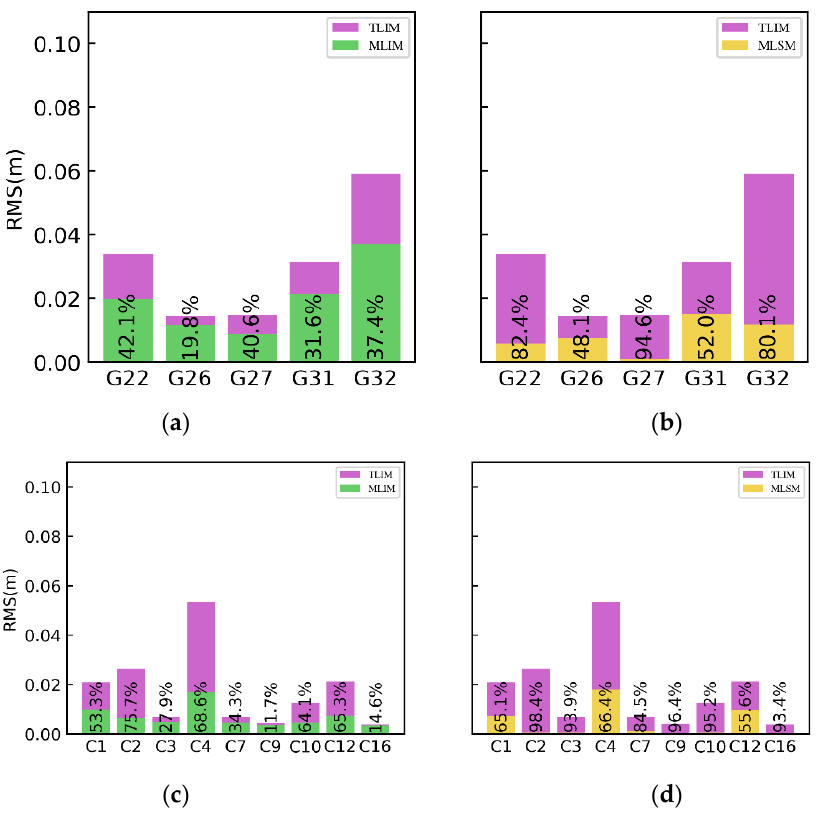
Figure 8. GPS ( a , b ) and BDS ( c , d ) satellites using the MLIM, TLIM, and MLSM interpolation methods to obtain the RMS of the DD tropospheric delay and the improvement ratios of MLIM and MLSM.